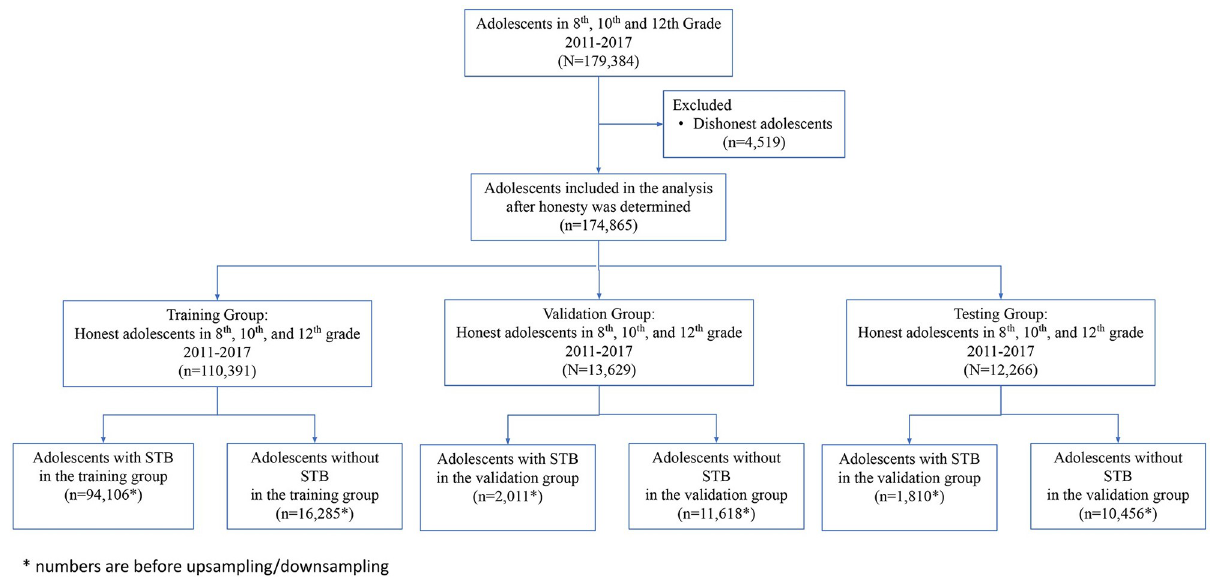
Fig 1. Flow chart of the predictive modeling process. Starting with the initial dataset, we show the process of how we trained and validated our models.